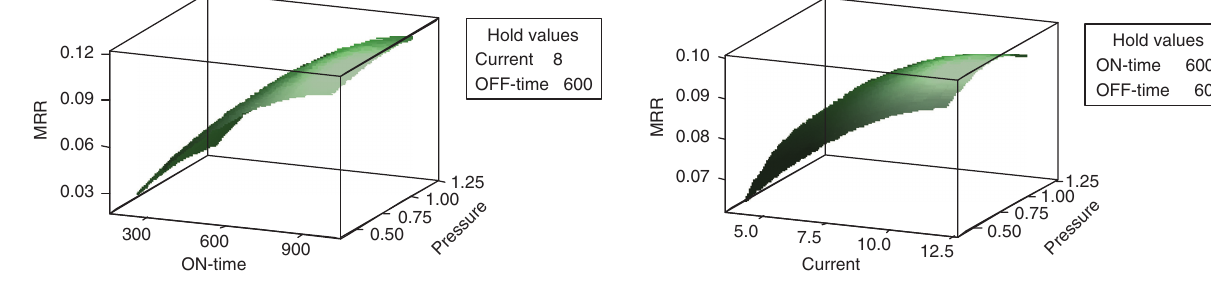
Figure 6 Surface plot of MRR vs. pressure,